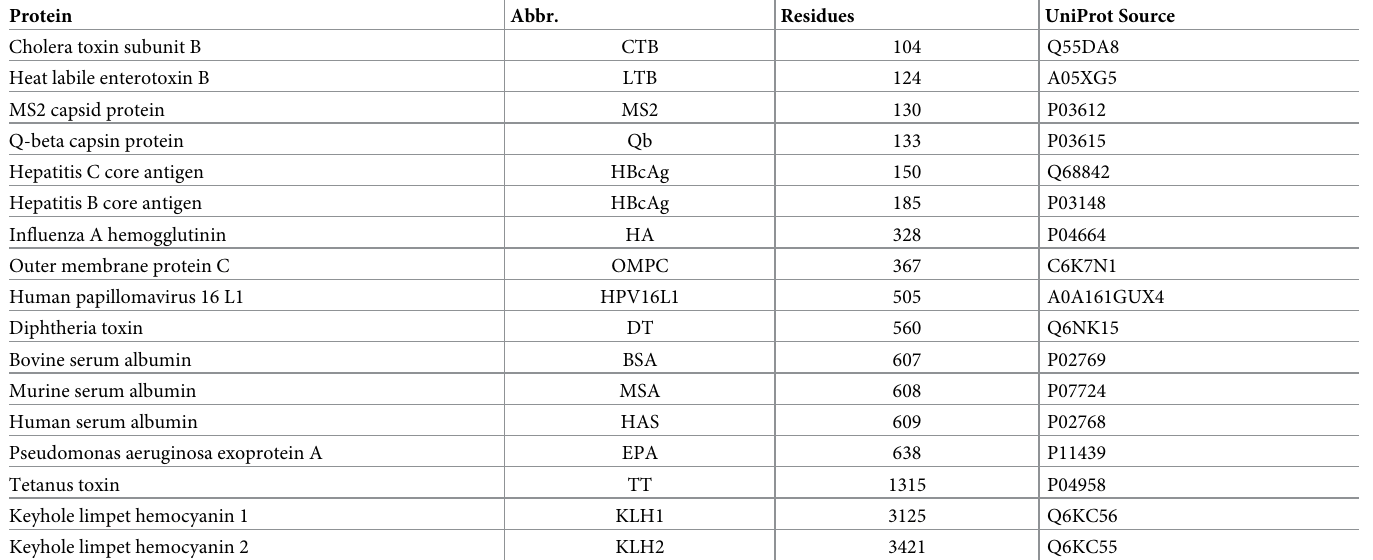
Table 1. Common immunogen